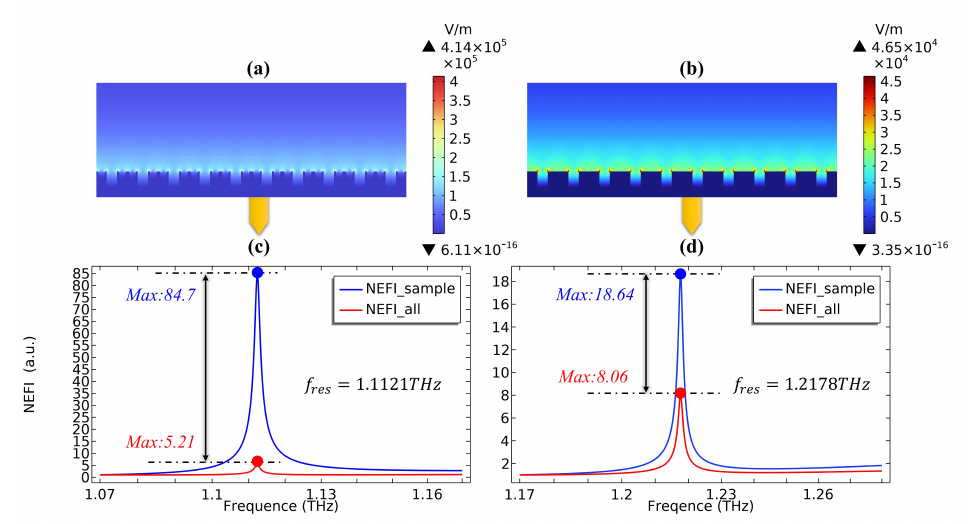
Figure 4. Electric field of SSPPs based on CPSGS ( a ) and CPGS ( b ), and its corresponding NEFI ( c ), ( d ) in the sample domain and the total calculation domain.